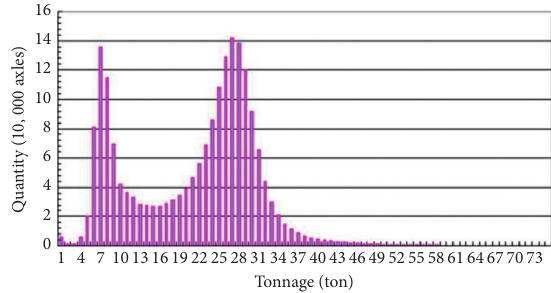
Figure 10: Triple-axle load spectrum.